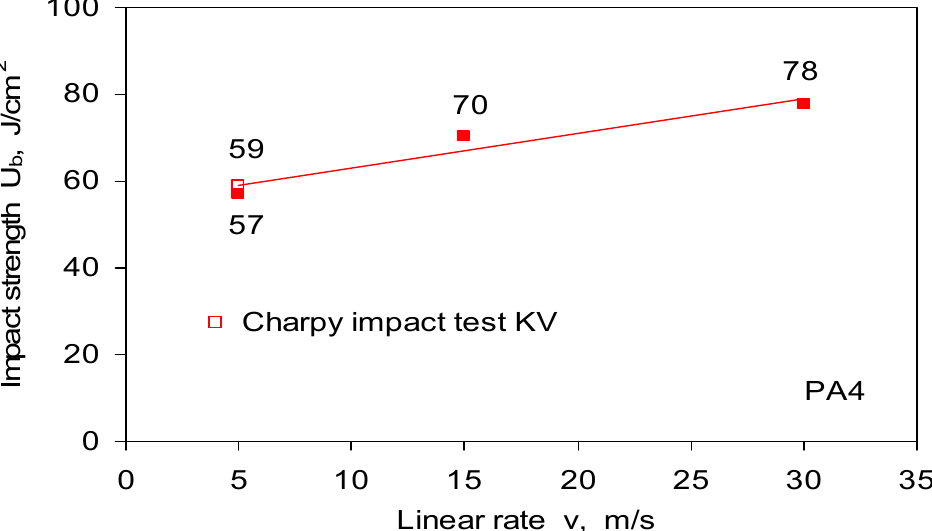
Figure 11. Toughness in tests of dynamic bending of PA4 aluminum alloy on rotational hammer. In the graph, for comparison, the impact result obtained on the Charpa pendulum was applied.